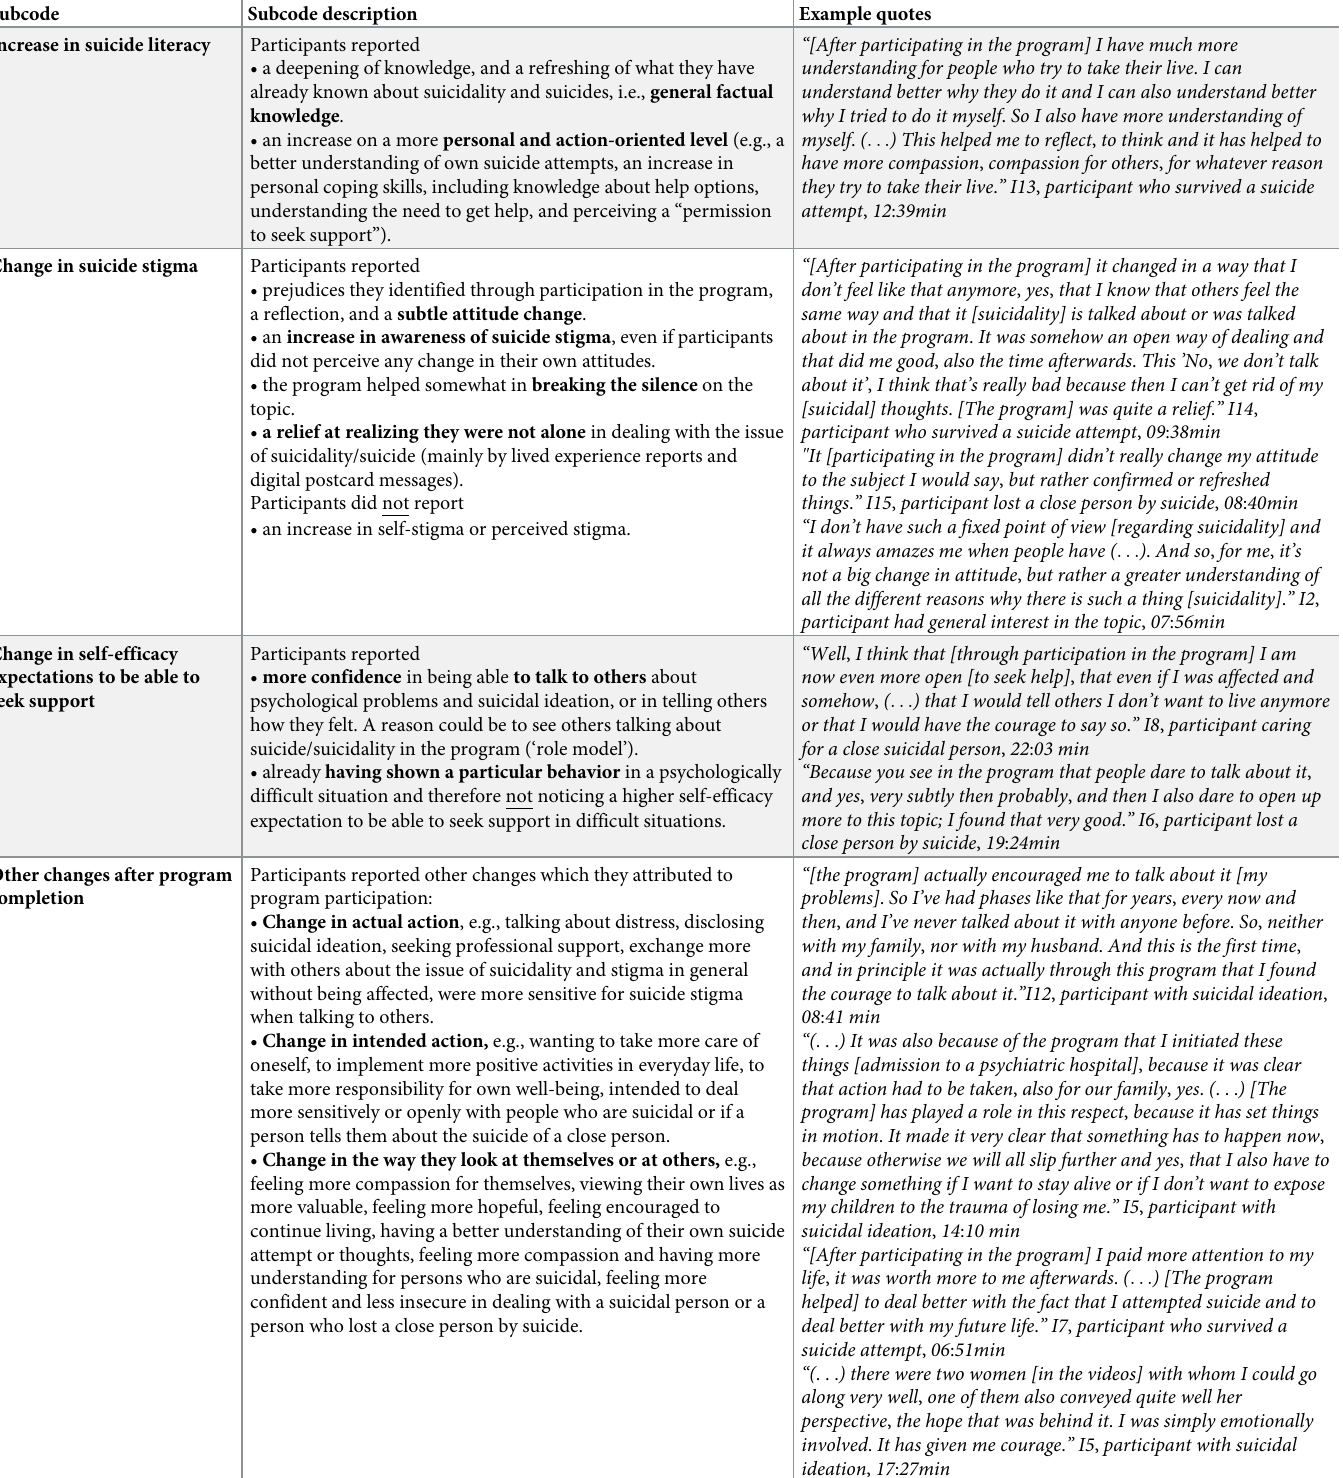
Table 4. Identified subcodes of main code “achievement of program objectives” and example quotes from the 16 follow-up telephone interviews 12–26 weeks after program